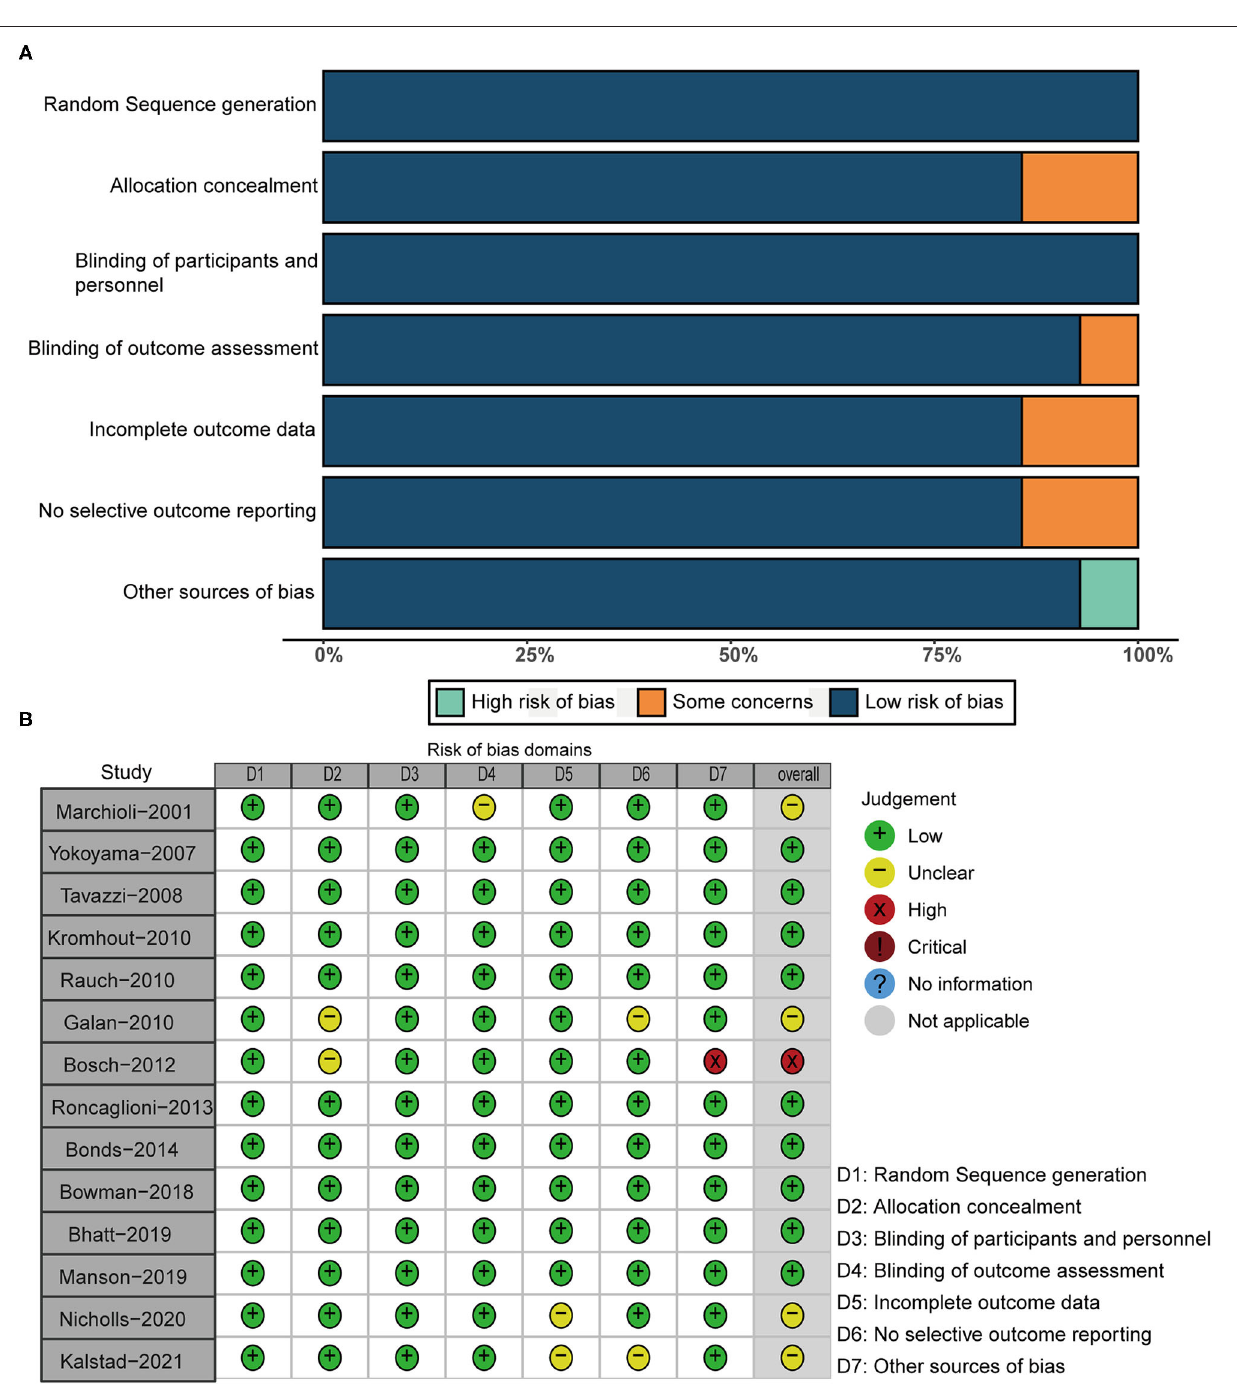
Diabetes or Not Two RCTs reported MACE events in patients with diabetes, including 28,199 diabetic subjects and 26,187 non-diabetic subjects (12, 13, 27). Administration of omega-3 FA supplementation in patients with diabetes or non-diabetes